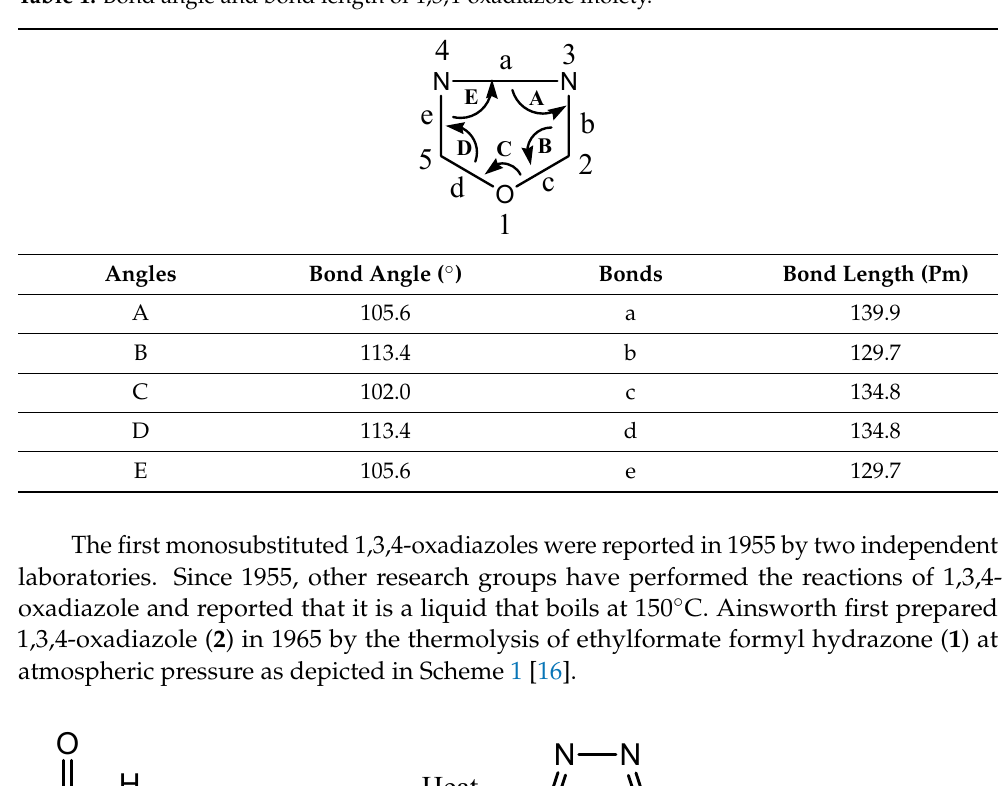
Table 1. Bond angle and bond length of 1,3,4-oxadiazole